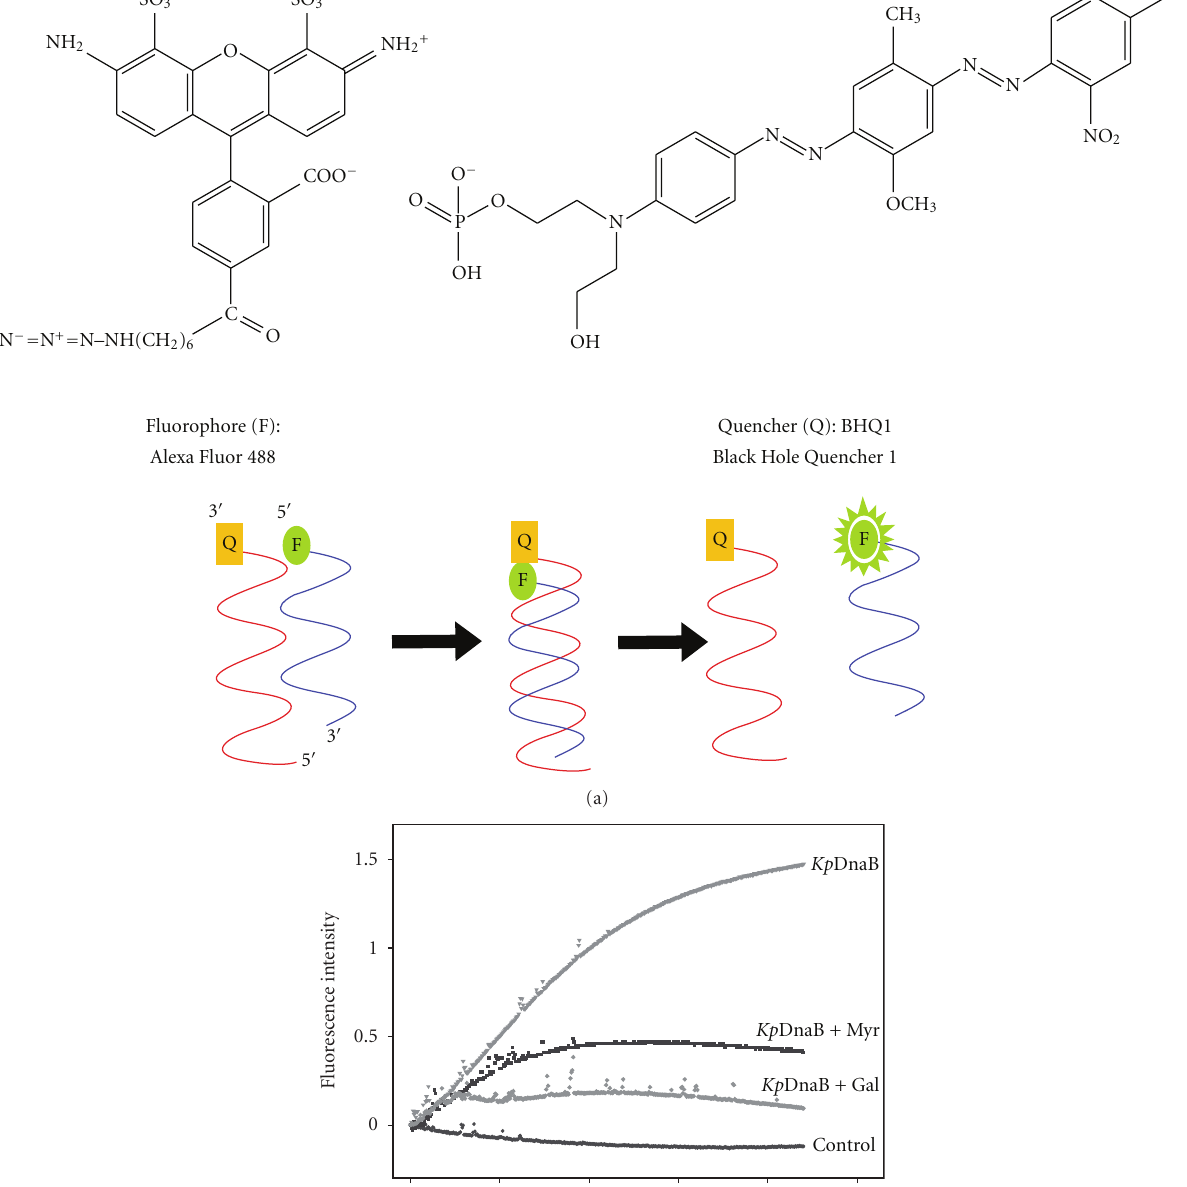
to nucleotides, thus interfering with the growth of K